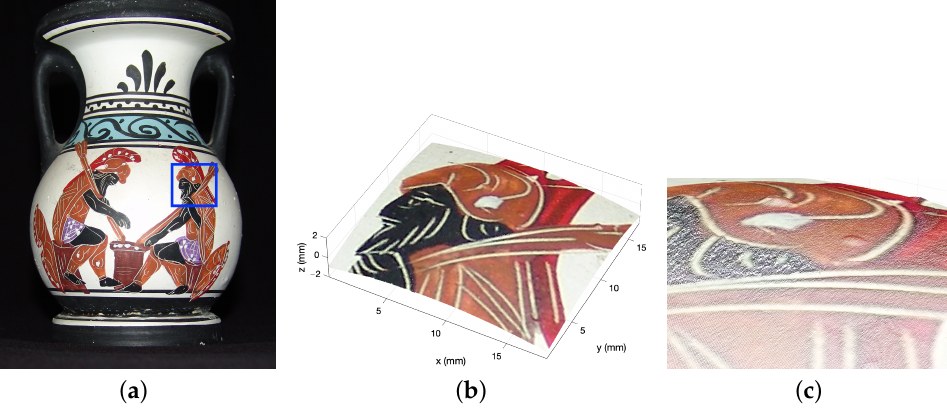
Figure 8. Spatial registered profilometry on 3D polychrome artifacts. ( a ) Visible image of the vase with the analyzed ROI highlighted in blue. ( b , c ) Visualization of analyzed surface data as point cloud onto which the visible texture is mapped